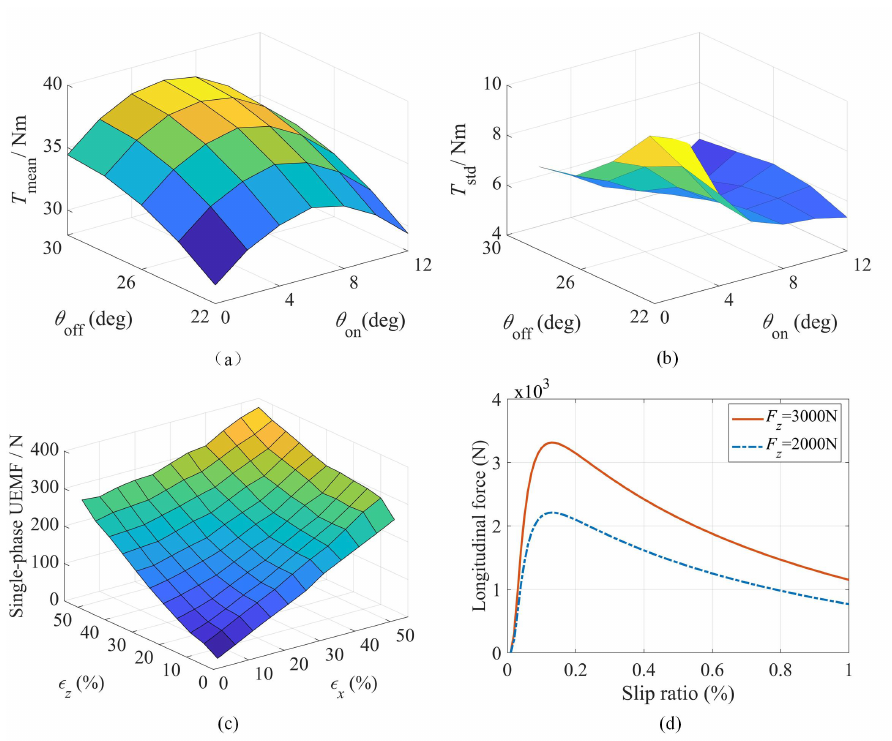
Figure 3. The IWM characteristics: ( a ) T mean versus turning angle; ( b ) T std versus turning angle; ( c ) single-phase UEMF of SRM; ( d ) the magic